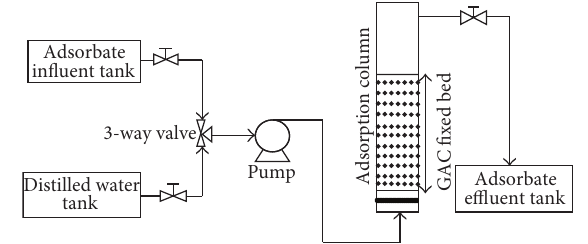
F 1: Schematic �ow diagram of �xed bed system onto